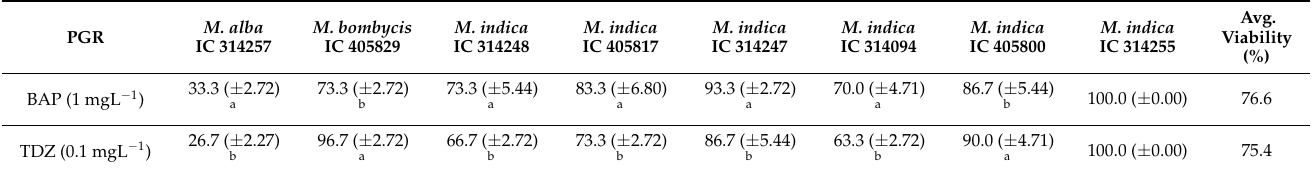
Table 3. Effect of different plant growth regulators (PGRs) on viability percentage of dormant buds of different Morus species.